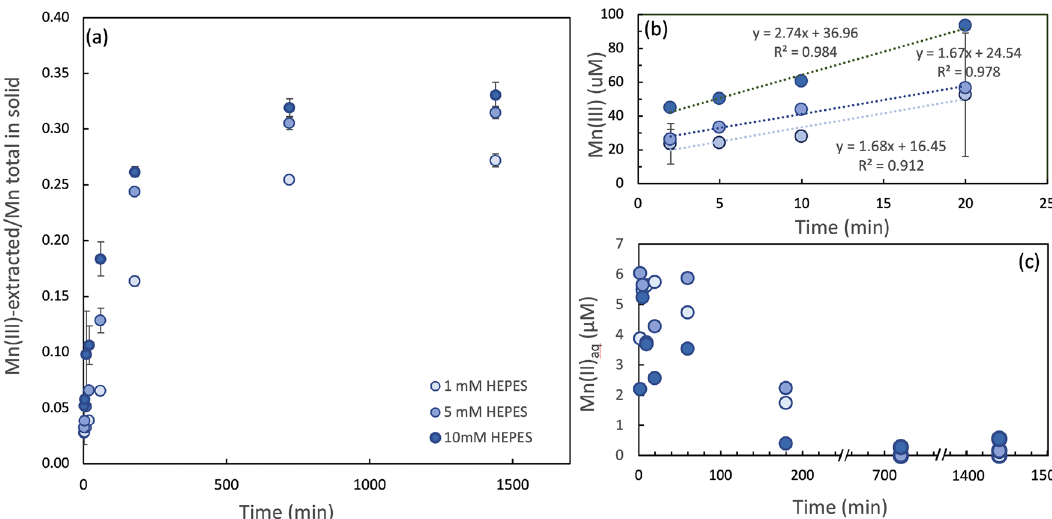
Figure 3. ( a ) Effect of HEPES concentration on the kinetics of Mn reduction in δ-MnO 2 at pH 7.5 as quantified by pyrophosphate extractions. ( b ) Initial rates of Mn(III) production as a function of total HEPES concentration. ( c ) Aqueous Mn(II) concentration over time; note the axis-break in ( c ). Error bars represent standard deviation of triplicates; when not visible, error bars are smaller than the marker